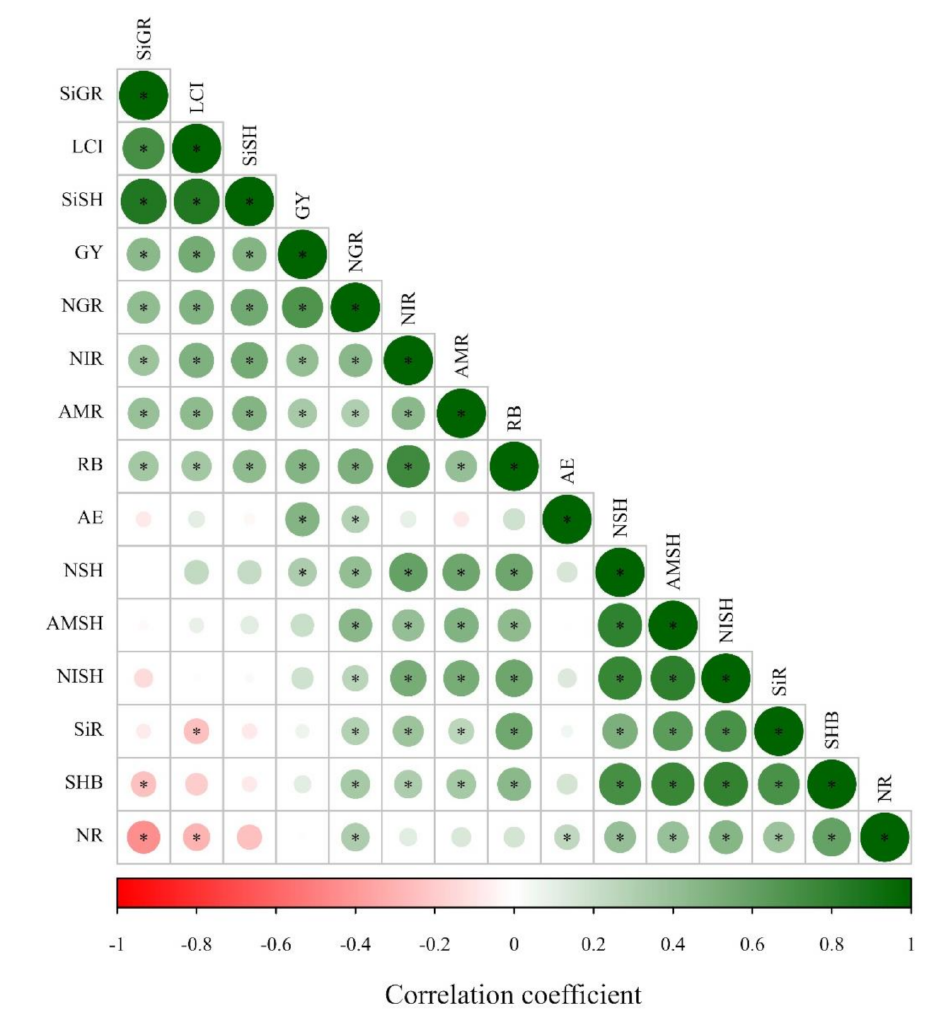
Figure 4. Heatmap showing the Pearson’s correlation among the analyzed parameters in wheat plants in response to Si application and N levels. * indicates significant relationship ( p ≤ 0.05). Abbreviation: NIR = N-NO 3 − accumulation in root, NR = total N accumulation in root, RB = root biomass, AMR = N-NH 4+ accumulation in root, SiR = Si accumulation in root, AE = agronomic efficiency, NISH = N-NO 3 − accumulation in shoot, LCI = leaf chlorophyll index, SiSH = Si accumulation in shoot, SHB = shoot biomass, AMSH = N-NH 4 + accumulation in shoot, NGR = total N accumulation in grain, GY = grain yield, NSH = total N accumulation in shoot, SiGR = Si accumulation in